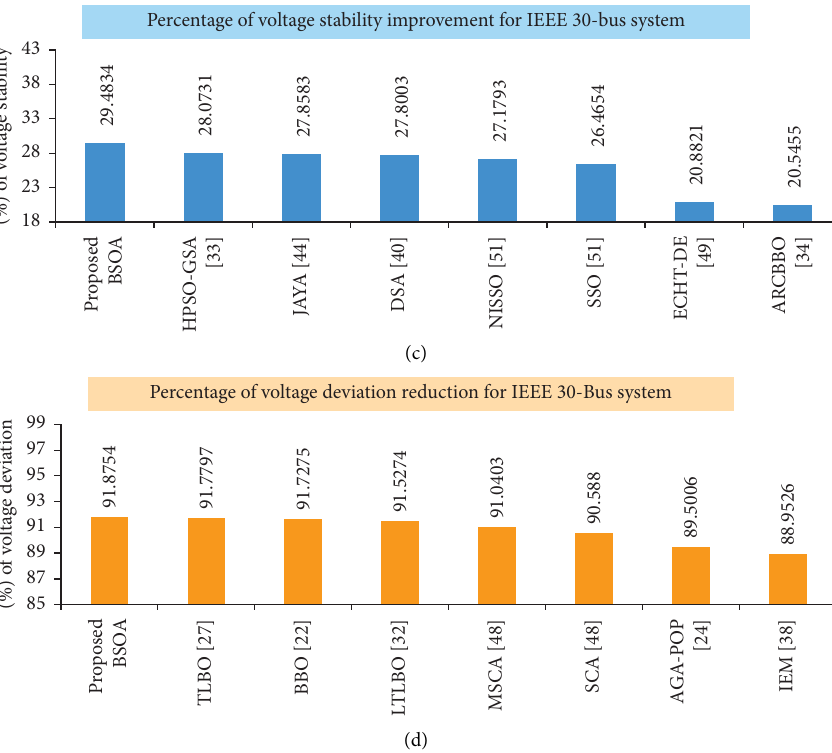
Figure 6: Percentage of fuel cost savings, active power loss reduction, voltage stability improvement, and voltage deviation reduction of the IEEE 30-bus system from base case: (a) fuel cost saving (Case 1); (b) active power loss reduction (Case 3); (c) voltage stability improvement (Case 5); (d) voltage deviation reduction (Case